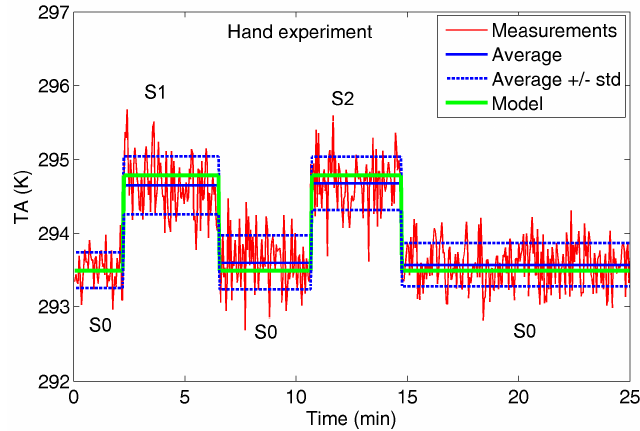
Figure 11. Hand experiment: T A measured by radiometer (red and blue curves) and estimated by model (green curve).